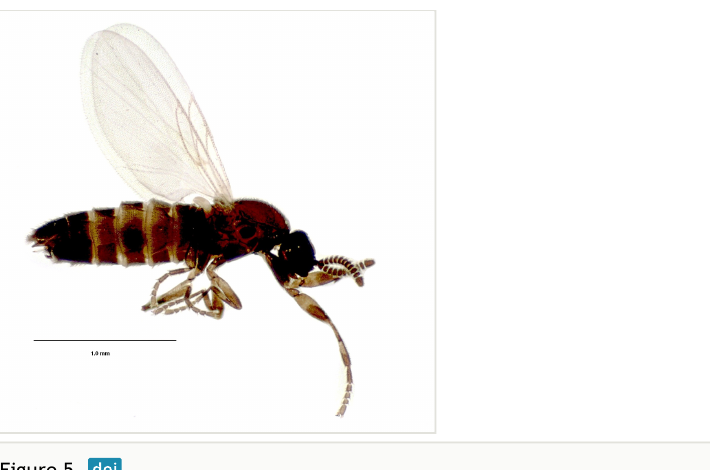
Figure 5. Ectaetia subclavipes Krivosheina,